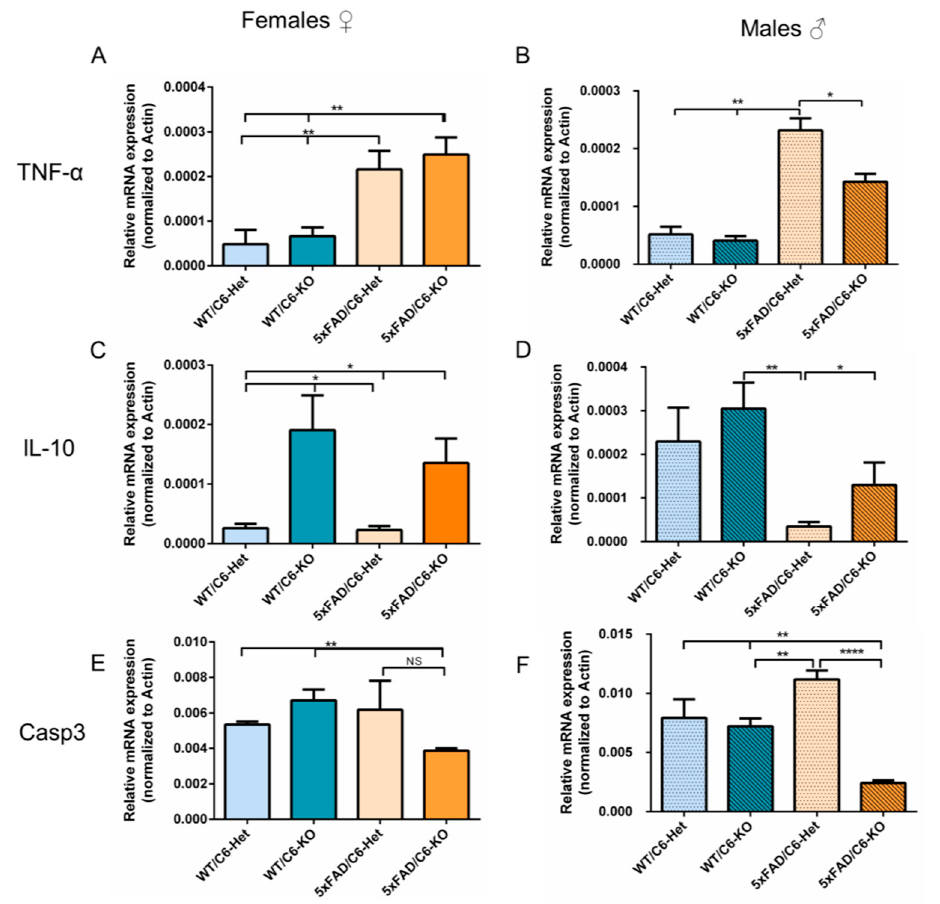
Figure 5. Altered gene expression in hippocampus of 5xFAD/C6-KO mice. Mice hippocampi were taken for RT-PCR analysis of several genes: mRNA quantification for female and male TNF- α ( A , B ), IL-10 ( C , D ); and Caspase-3 (Casp3; E , F ) respectively. Data are mean ± SEM. * p < 0.05, ** p < 0.01, and **** p < 0.0001. Two-tailed t-test between marked groups. NS: Not significant.